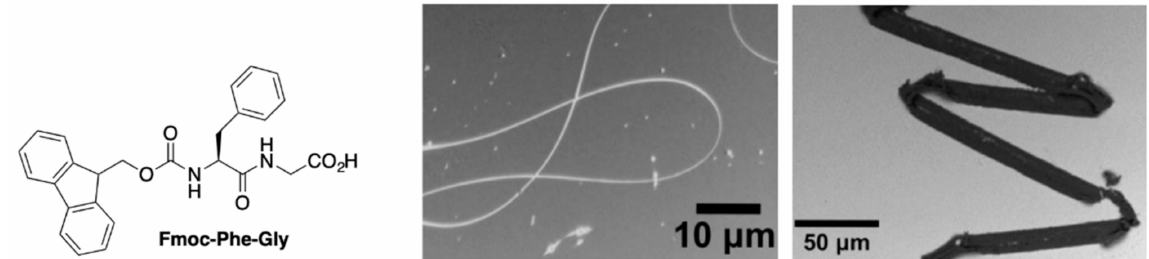
Figure 3. Band-like morphology of Fmoc-Phe-Gly electrospun nanofibers. Reproduced from [41] with permission from The Royal Society of Chemistry.